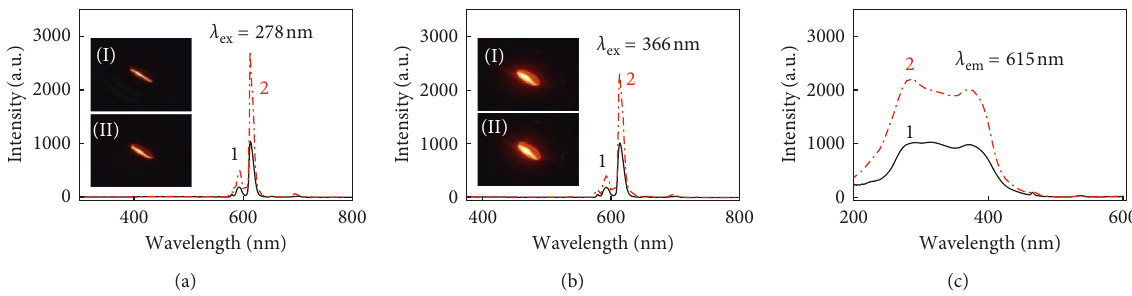
Figure 4: Emission (a, b) and excitation (c) spectra of Eu(BA)(TTA) Eu(BA)(TTA) 2 (I) and Eu(BA)(TTA) 2 Phen (II), respectively.